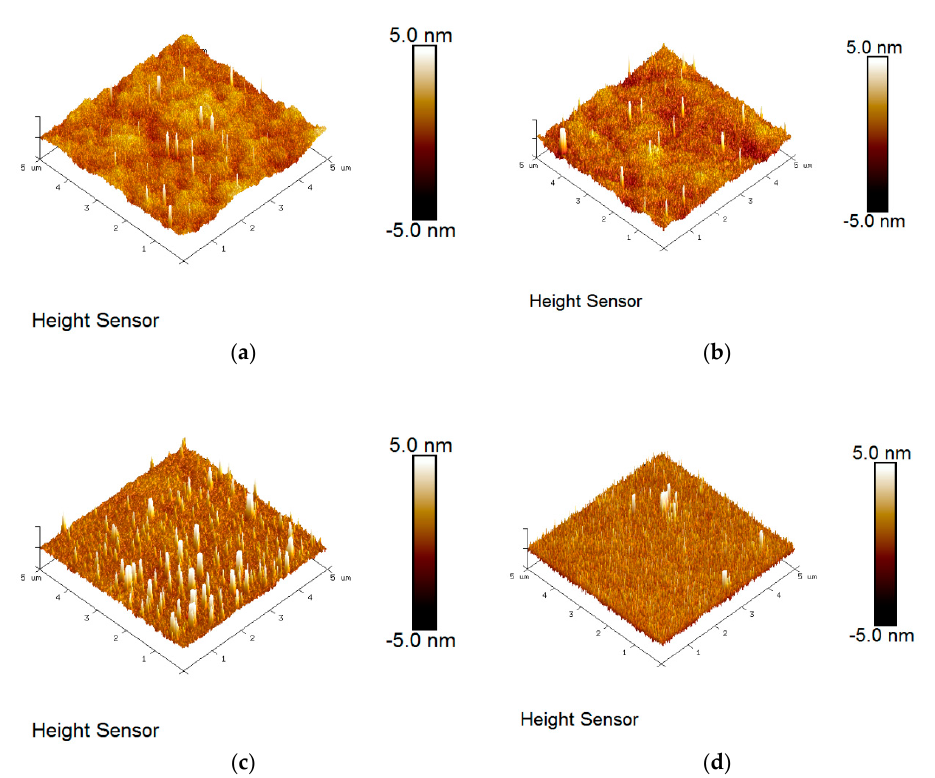
Figure 7. AFM 3D images showing different surface roughness of the Co 40 Fe 40 V 10 B 10 thin films with various thicknesses: ( a ) 10 nm, ( b ) 20 nm, ( c ) 30 nm, and ( d ) 40 nm.